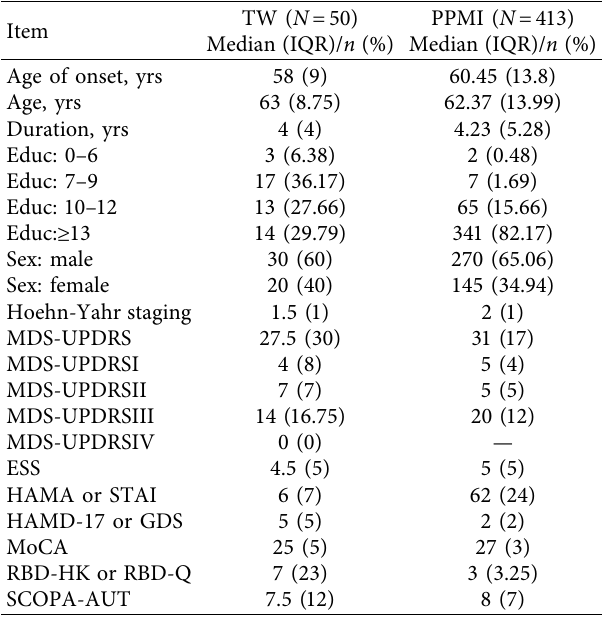
Table 1: Cohort demographics at